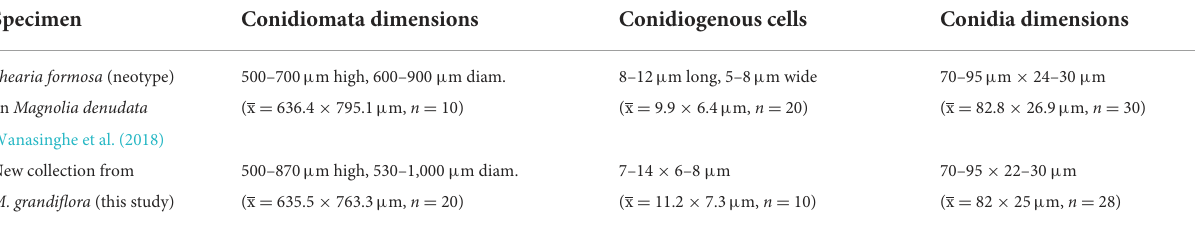
TABLE 5 Morphological comparison of new collection and neotype of Shearia formosa . Specimen Conidiomata dimensions Conidiogenous